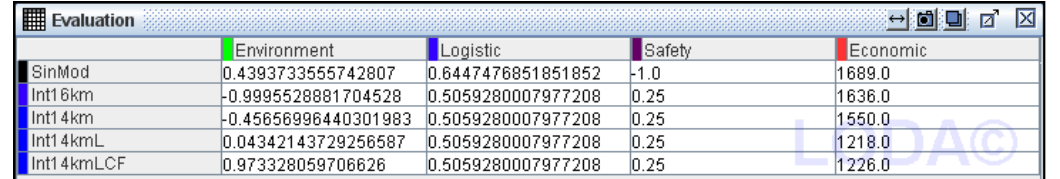
Figure 5. STPI Evaluation